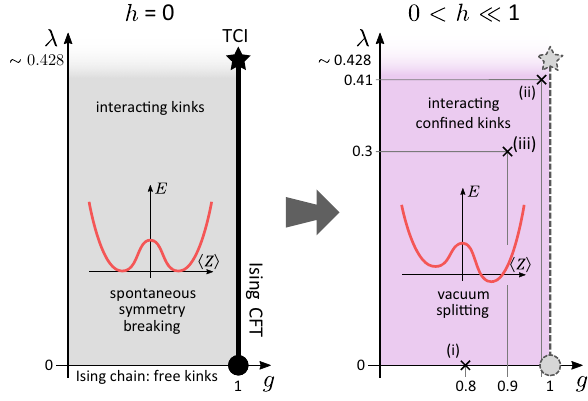
FIG. 3. Partial phase diagrams of the extended Ising chain [55,56], both without and with a small longitudinal field h that breaks the Z 2 symmetry. At h = 0, g = 1 there is a continu- ous (symmetry-breaking) phase transition described by the Ising CFT for λ (cid:2) 0.428, and by the tricritical Ising (TCI) CFT at λ ≈ 0.428. By studying the spin chain near to these transitions ( g → 1, h → 0), we can access emergent, relativistic quantum field theories with confined kinks [57,58]. Points (i), (ii), and (iii) correspond to the data shown in the figures